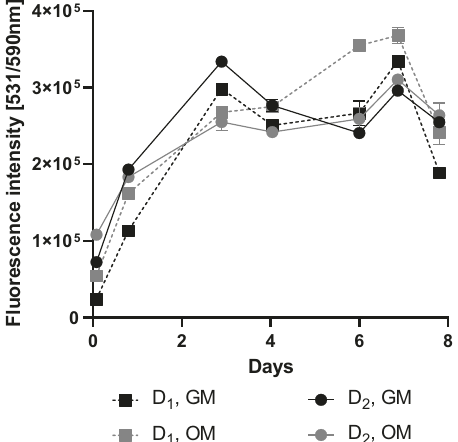
Fig. 3 The viability of BMSCs seeded on the scaffolds cultured with growth medium (GM) or osteogenic medium (OM). The viability was measured with AlamarBlue. D 1 Donor 1, D 2 Donor 2